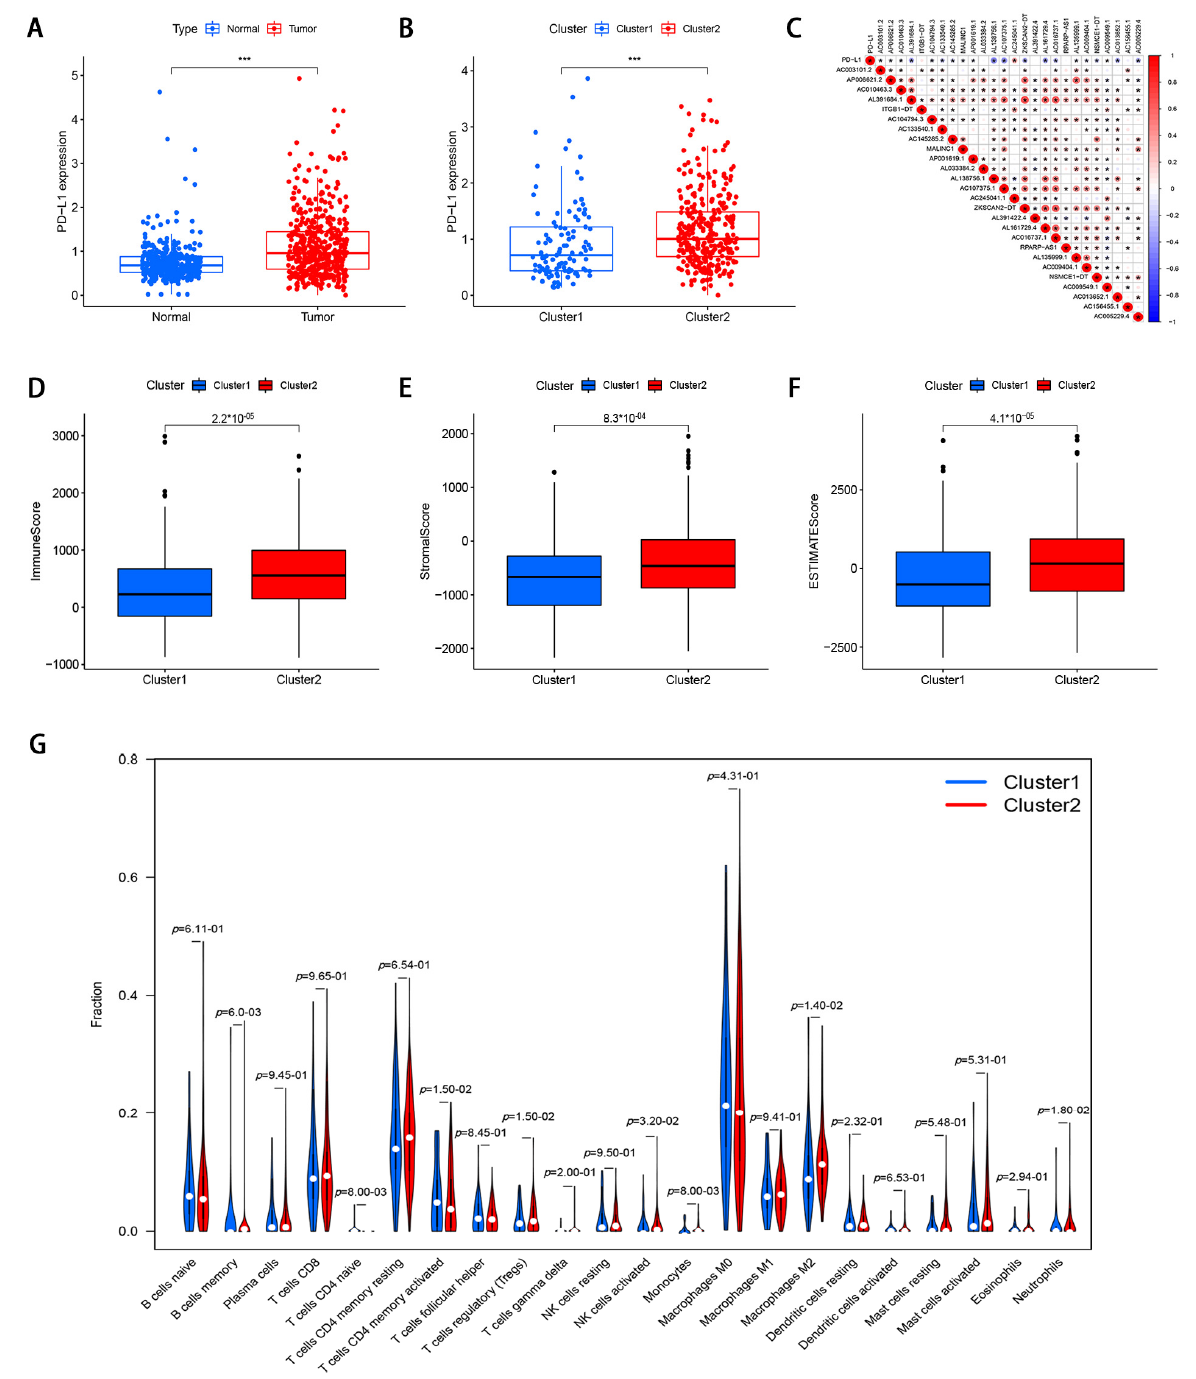
Figure 3. The correlation of m6A-modified lncRNA with PD-L1 and tumor immune cell microenvironment in CRC. ( A ) The expression level of PD-L1 in CRC tissues and normal adjacent tissues. ( B ) The expression level of PD-L1 in cluster 1 and cluster 2 (*** p < 0.001). ( C ) The correlation of PD-L1 with m6A-modified lncRNA. ( D – F ) immune score, stromal score, and ESTIMATE score in cluster 1 and cluster 2. ( G ) The infiltrating levels of 22 immune cell types in cluster 1 and cluster